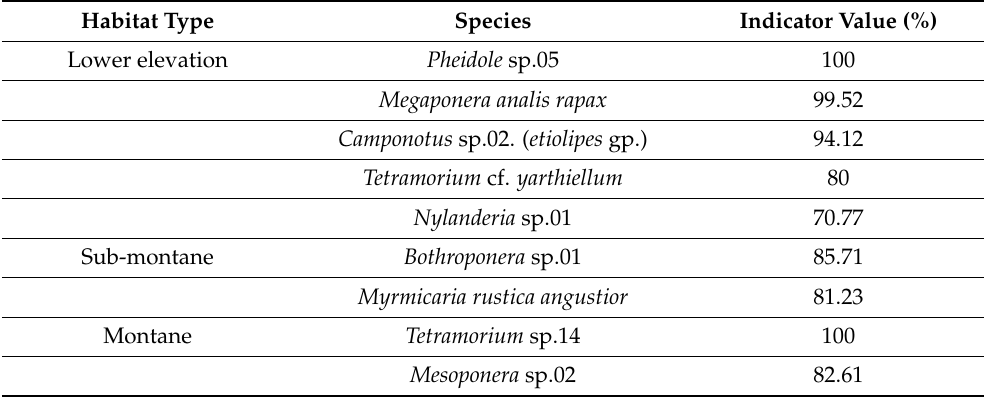
Table 4. Indicator values (IndVal) of ant species for forest habitat types along the elevational transects. All indicator values are significant ( p <